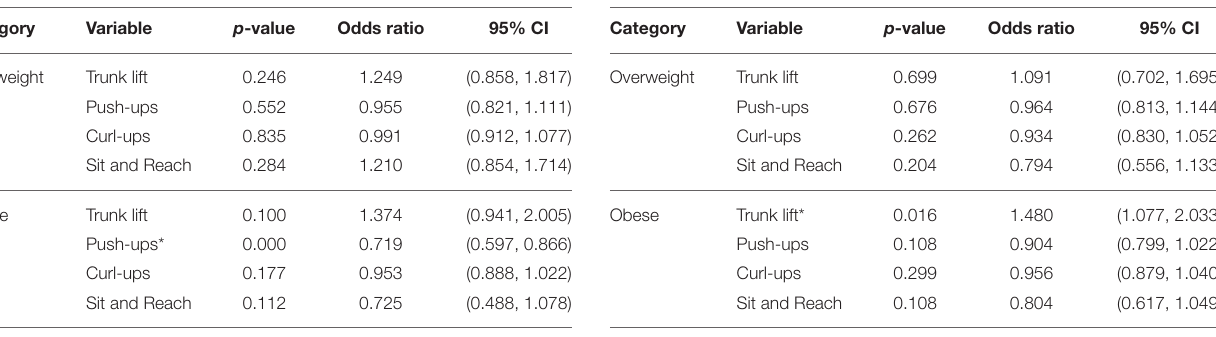
TABLE 5B | Associations between musculoskeletal fitness and weight status in third grade (reference group: obese). Category Variable Overweight